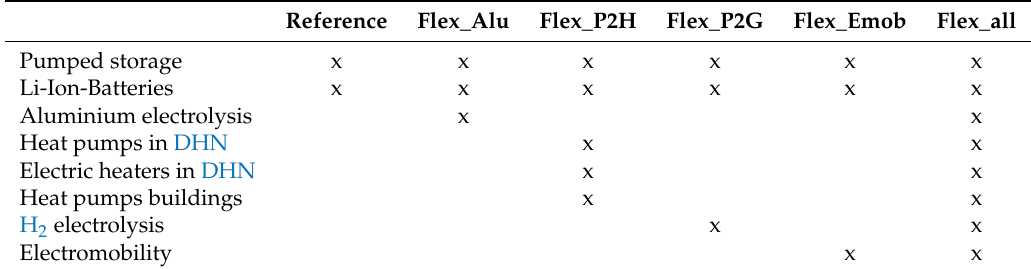
Table 3. Overview about configuration of considered flexibility option in the simulation